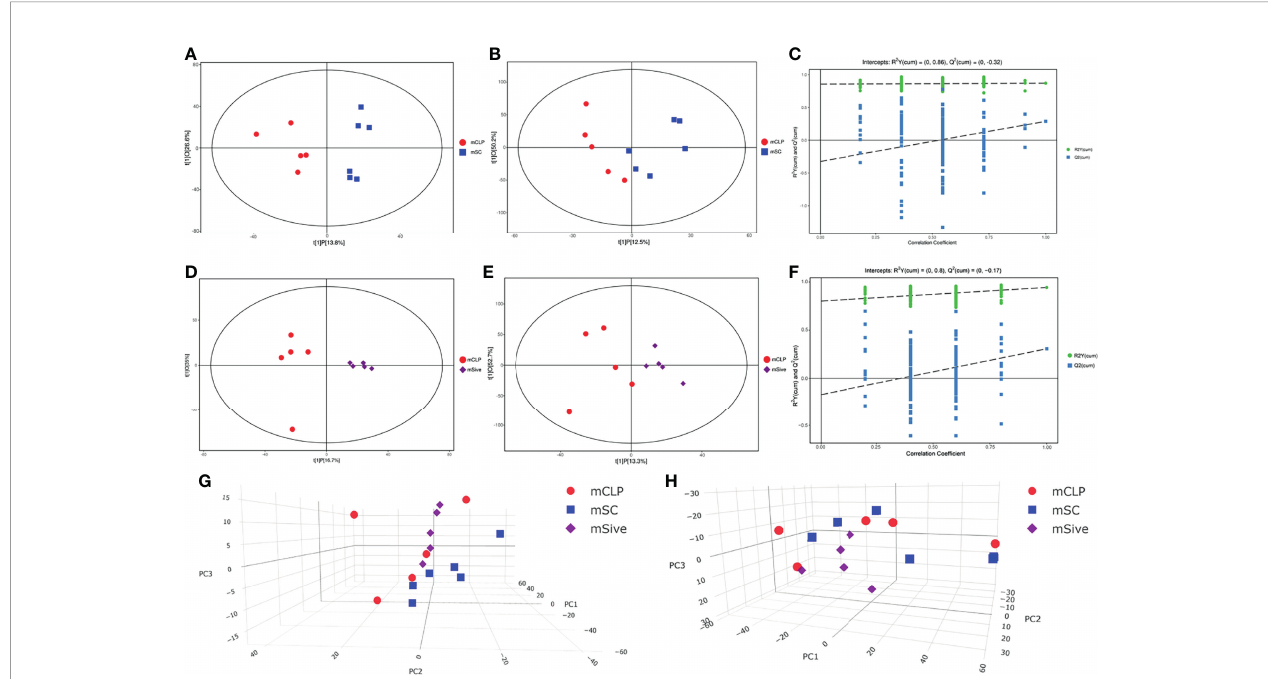
FIGURE 4 | (A – C) Score scatter plot and Permutation test of the OPLS-DA model for the CLP and SC groups. (D – F) Score scatter plot and Permutation test of the OPLS-DA model for the Sive and CLP groups. (E, F) PCA scores of experimental groups. (A, C, D, F, G) Negative ion mode. (B, E, H) Positive ion